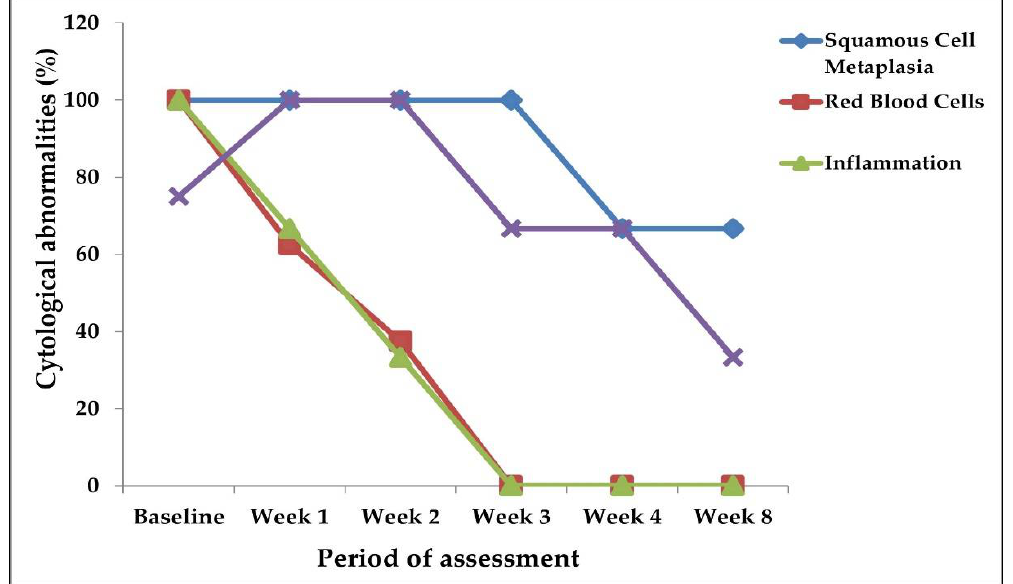
Figure 4. Cytological changes at baseline and